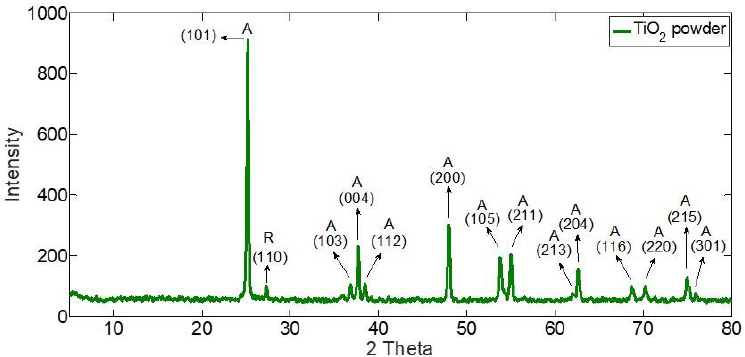
Figure 8. XRD patterns for TiO 2 nanoparticles.